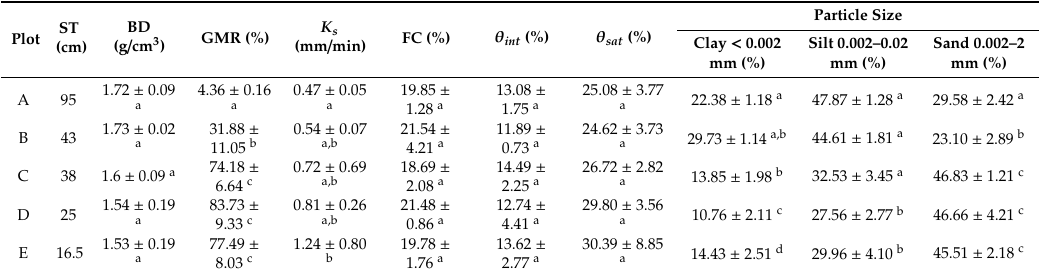
Figure 3. The examples of the typical vertical soil section of Plot ( A )–( E ). Table 2. Mean soil physical properties of the experimental plots on the hillslope (A: bottom; B: lower; C: middle; D: upper; E: